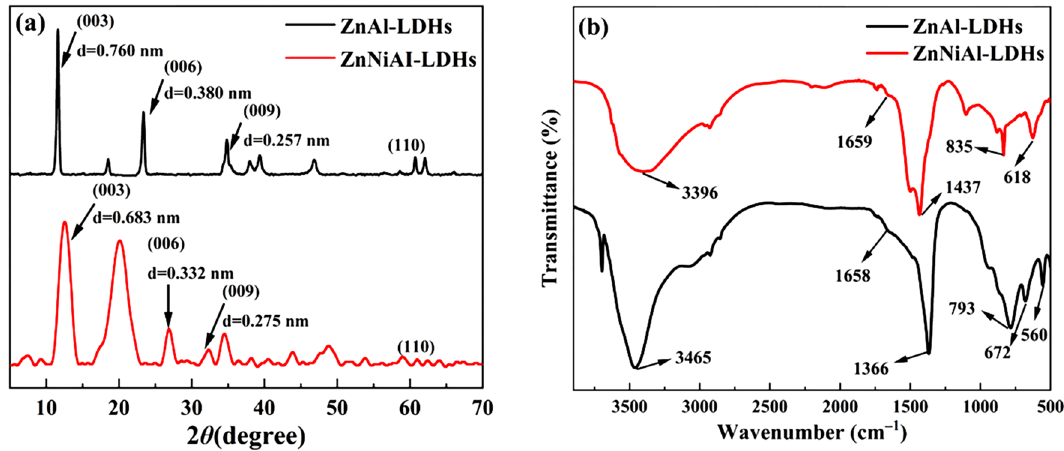
Figure 1. XRD patterns ( a ) and FT-IR patterns ( b ) of ZnAl-LDHs and